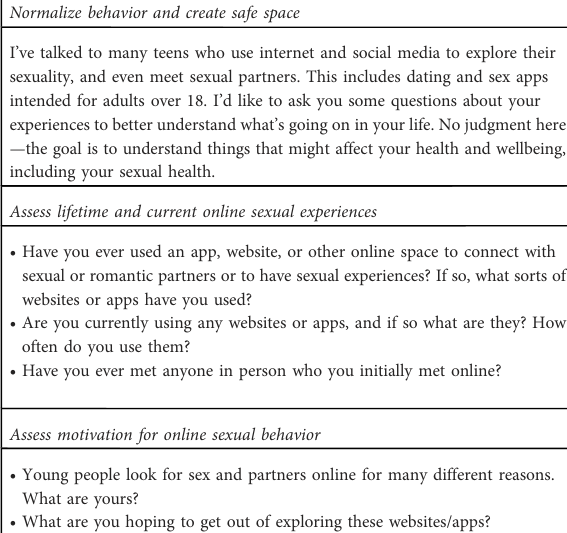
TABLE 2 Sample questions for clinicians to ask adolescents about online sexual and relationship experiences. Normalize behavior and create safe